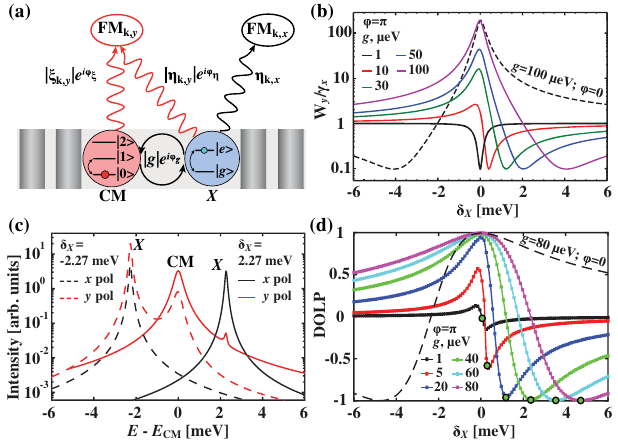
FIG. 4. (a) Schematic representation of radiative FM and CM channels to y - and x -polarized modes. (b) Calculated exciton emission rates W ð δ as a function of exciton-CM detuning δ X Þ X for different exciton-CM coupling strengths g and the phase differences φ . (c) Numerically simulated polarization-resolved spectra for negative and positive detuning δ . (d) DOLP traces as X 0 . 4 , p 0 . 29 , different exciton-CM a function of δ for p X X ¼ CM ¼ coupling strengths g , and relative phases φ . The green filled cir- ; D cles represent analytically calculated coordinates ð δ of ext ext Þ minima in DOLP